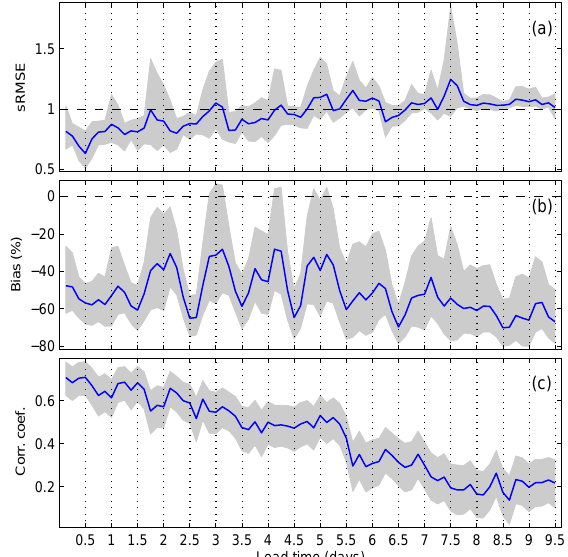
Fig. 11. As in Fig. 6, but for the catchment average precipitation above Wangaratta stream gauging station: (a) aRSME, (b) bias, and (c) Spearman rank correlation.